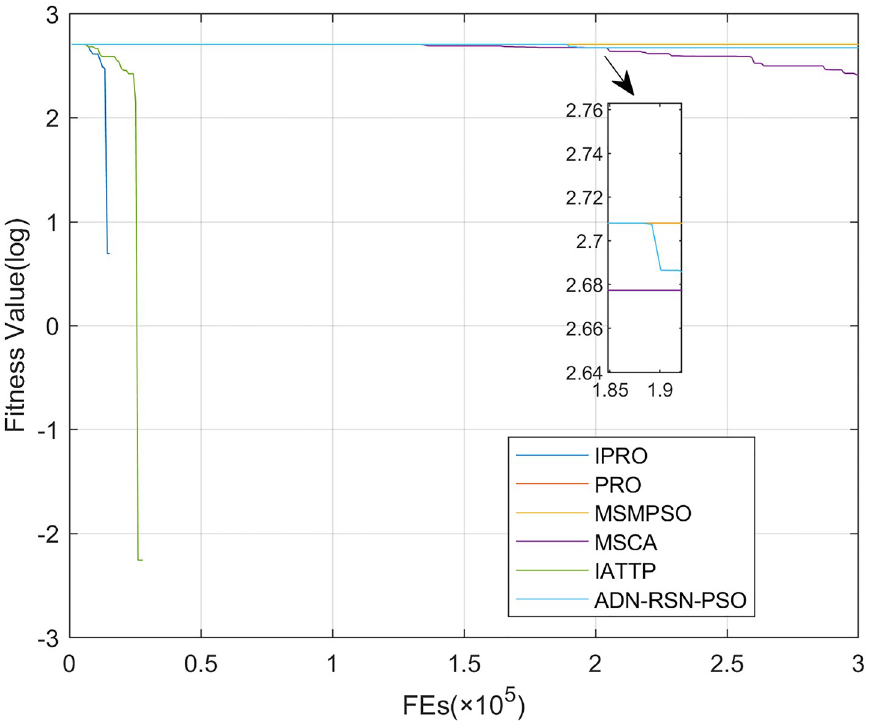
Fig 20. Convergence curves on